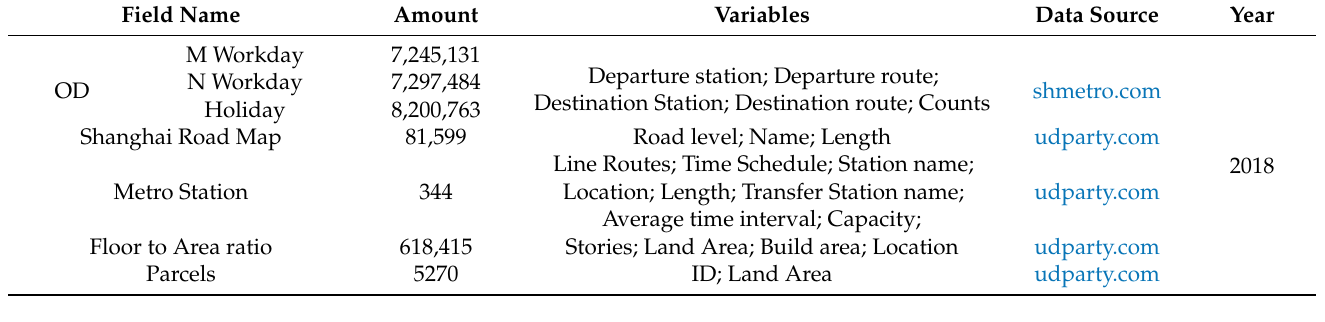
Table 1. Description of data sources.